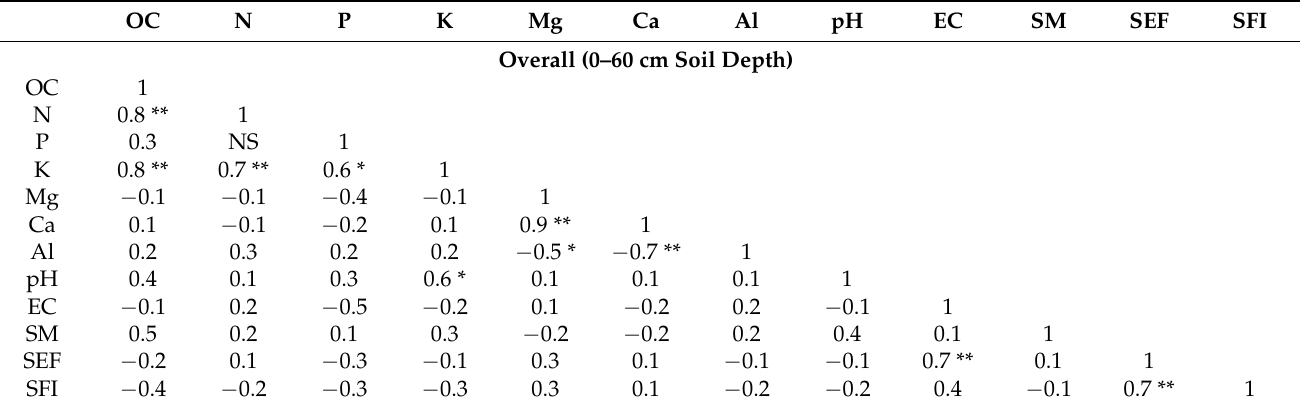
Table 6. Pearson correlation coefficients between different soil properties irrespective of stands and soil